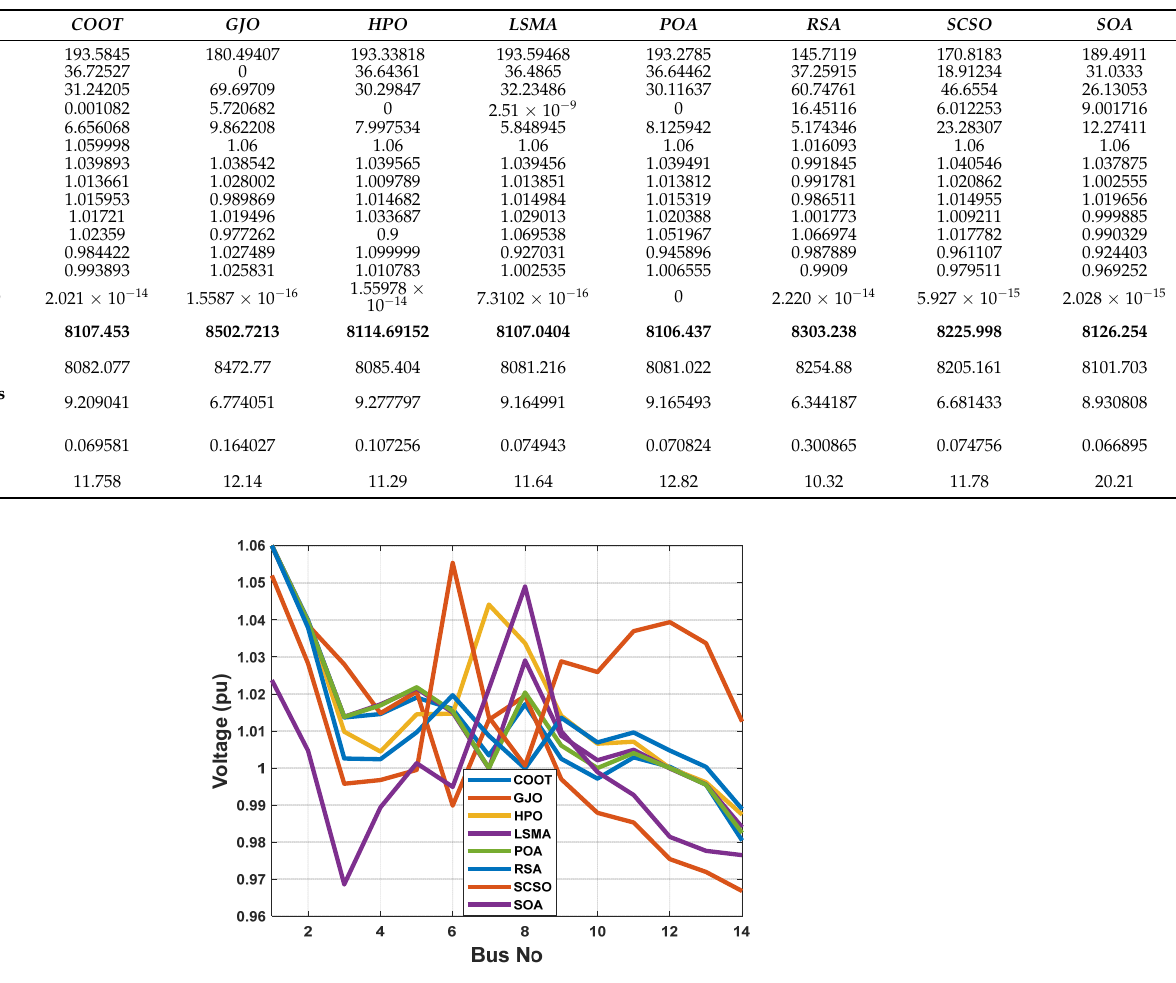
Figure 15. The voltage profile of the POA and other compared algorithms for case 5 in a standard IEEE 14-bus test system.